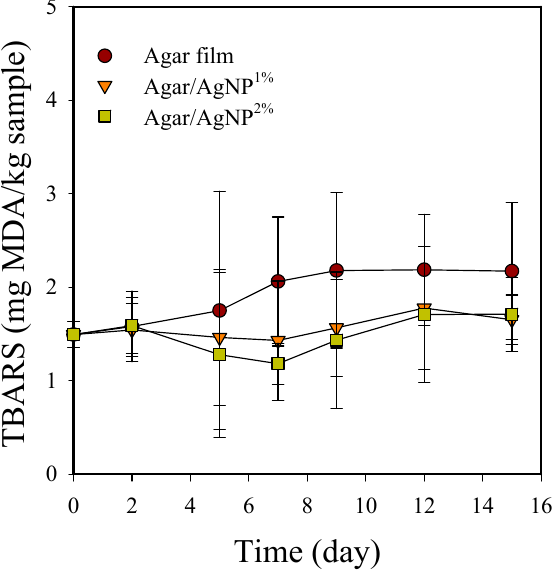
Figure 4. Changes in TBARS of beef samples packaged with agar/AgNP composite films. TBARS: LSD time = 0.59, LSD treatment = 0.39.